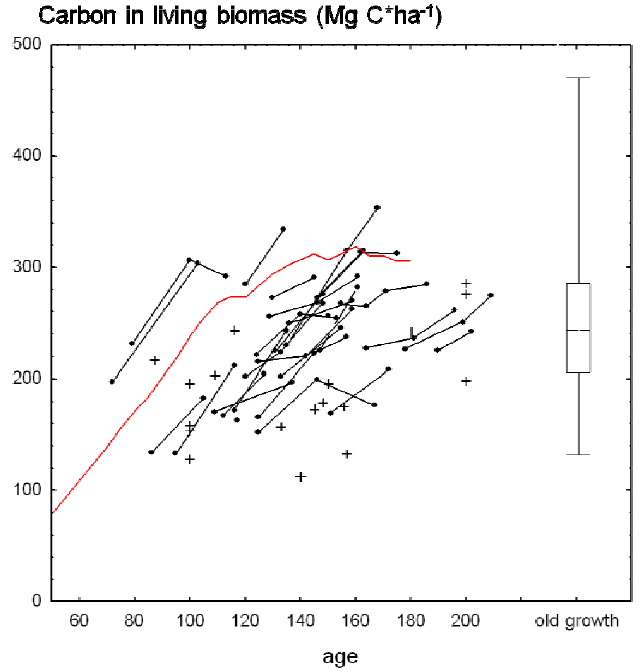
Figure 9. Carbon stock in living biomass (Mg C ha − 1 ) in the unmanaged stand for beech; the red line indicates the Silva model result, the dots the forest reserves of Bavaria where black lines show the development of a single stand, the crosses are other carbon stocks from literature [44–49] and the box-plot indicate the mean carbon stock in living biomass of old-growth forests without any age specification with standard deviation (box) and minimum and maximum (whiskers) from the literature